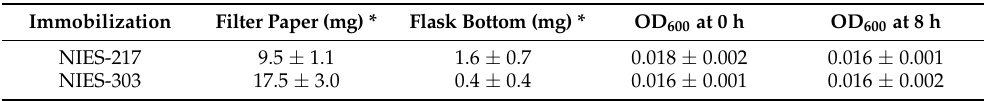
Figure 2. Observations of P. margaritaceum NIES-303 culture, the immobilized cells, and soaking of the immobilized cells in the Pb solution. The algal culture ( A ) was filtrated using filter paper to prepare the immobilized cells ( B ), which was soaked in the Pb solution with gentle shaking for 8 h ( C ). Table 1. Dry weights of the immobilized algal cells and insoluble materials at the bottom of the flask after soaking, and the optical densities at 0 h and after soaking.